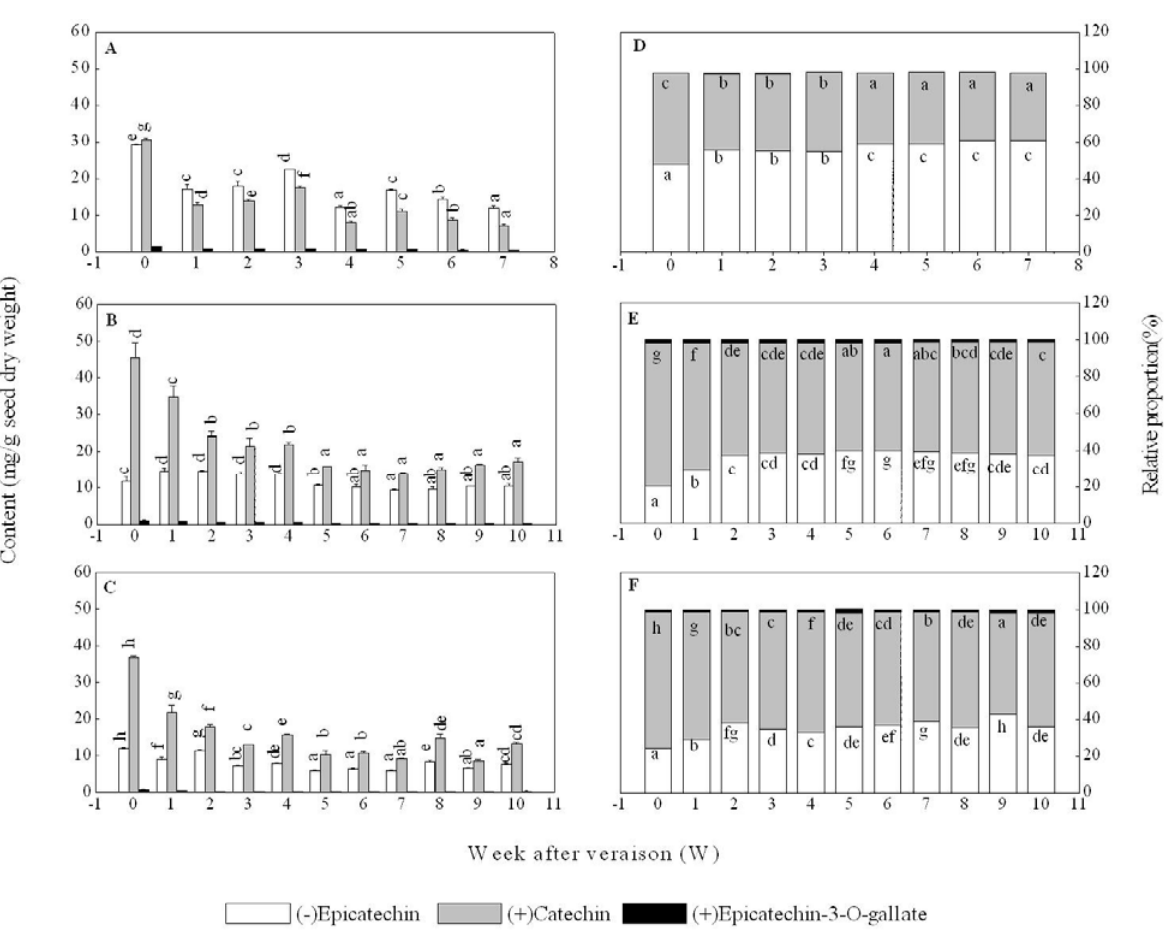
Figure 3. Changes in content and relative proportion of (-)-epicatechin, (+)-catechin and (-)-epicatechin-3-o-gallate in ‘Shiraz’ (A, D), ‘Cabernet Sauvignon’ (B, E) and ‘Marselan’ (C, F) grape seeds after